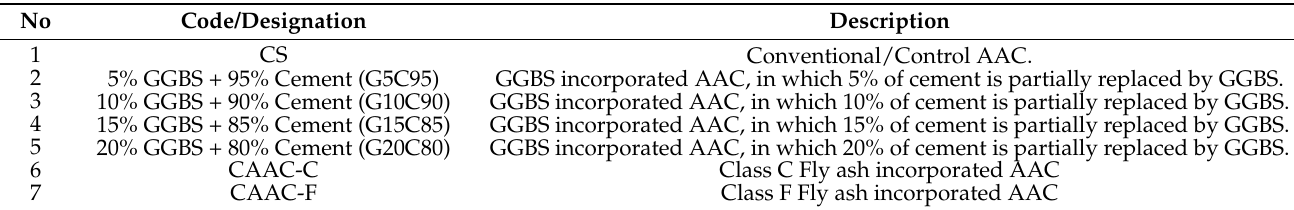
Table 2. Designation of specimens.